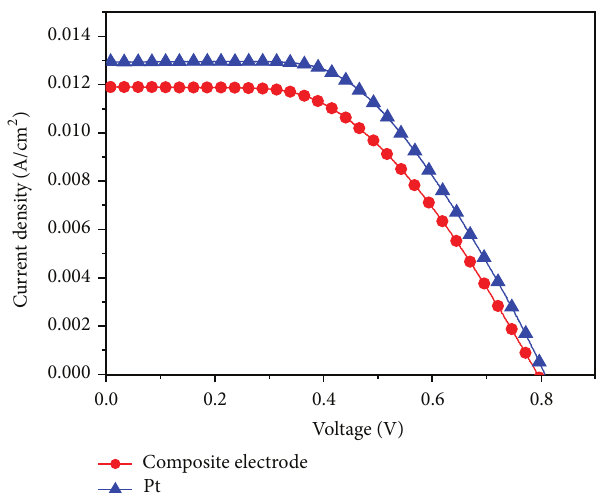
Figure 8: I-V characteristic curves of DSSCs with the composite films and Pt, respectively. Table 1: 𝑅1 , 𝑅2 , and CPE1 values of DSSCs with the composite films and Pt.